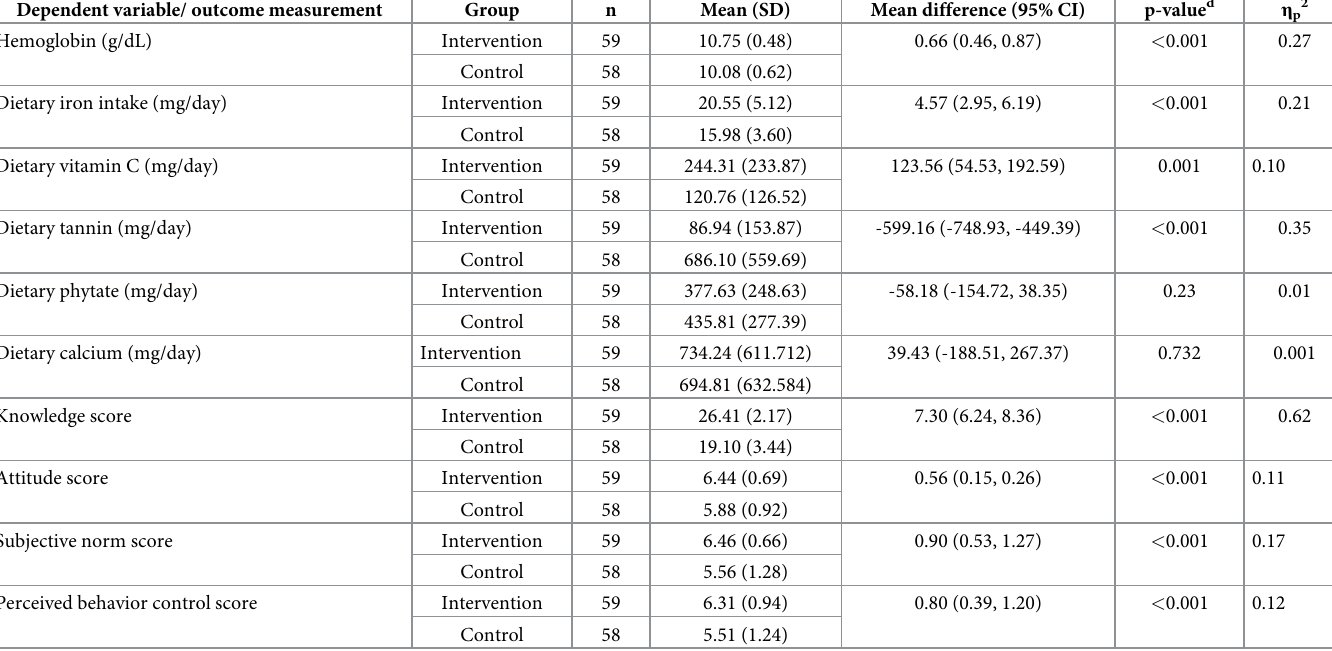
Table 5. Comparison of effect size and mean difference of each dependent variable between intervention and control groups at week 6 (immediately after the intervention). Dependent variable/ outcome